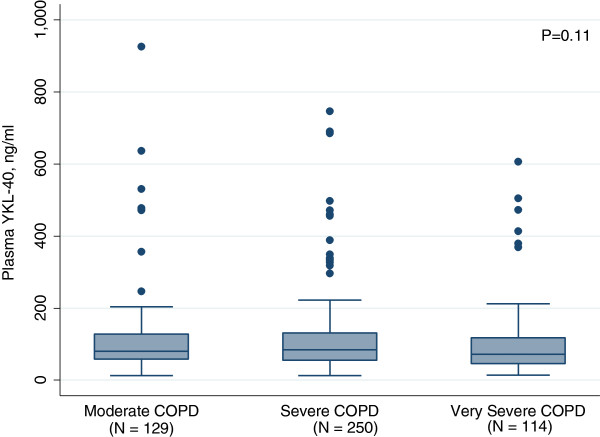
Plasma YKL-40 and COPD severity. Boxplots of plasma concentrations of YKL-40 in patients with COPD according to disease severity. Moderate COPD (79–50 FEV1 % predicted), severe COPD (30–50 FEV1 % predicted) and very severe COPD (< 30 FEV1 % predicted). The median score is the line in the middle of the box, and the 25th and 75th percentiles are the lower and upper part of the box. The whiskers are the 5th and 95th percentiles. Outliers are given as dots. No significant differences were found (Kruskal-Wallis test).